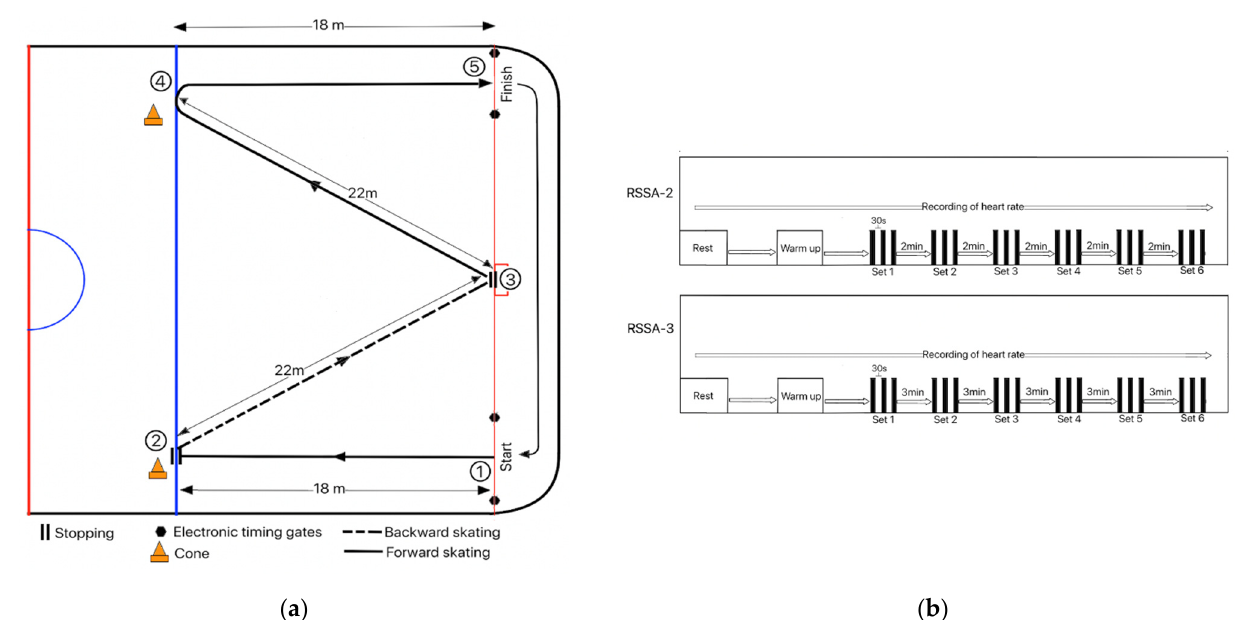
Figure 1. ( a ) Direction and distance of sprint skating in the repeated sprint skating ability test; ( b ) Schematic presentation of the overall study protocol. It illustrates 6 sets of RSSA tests with two different recovery periods between the sets—RSSA-2, with recovery period of 2 min, and RSSA-3, with recovery period of 3 min. It also shows that heart rate was recorded continuously, starting from rest till the end of the 6th set of both RSSA-2 and RSSA-3 tests.